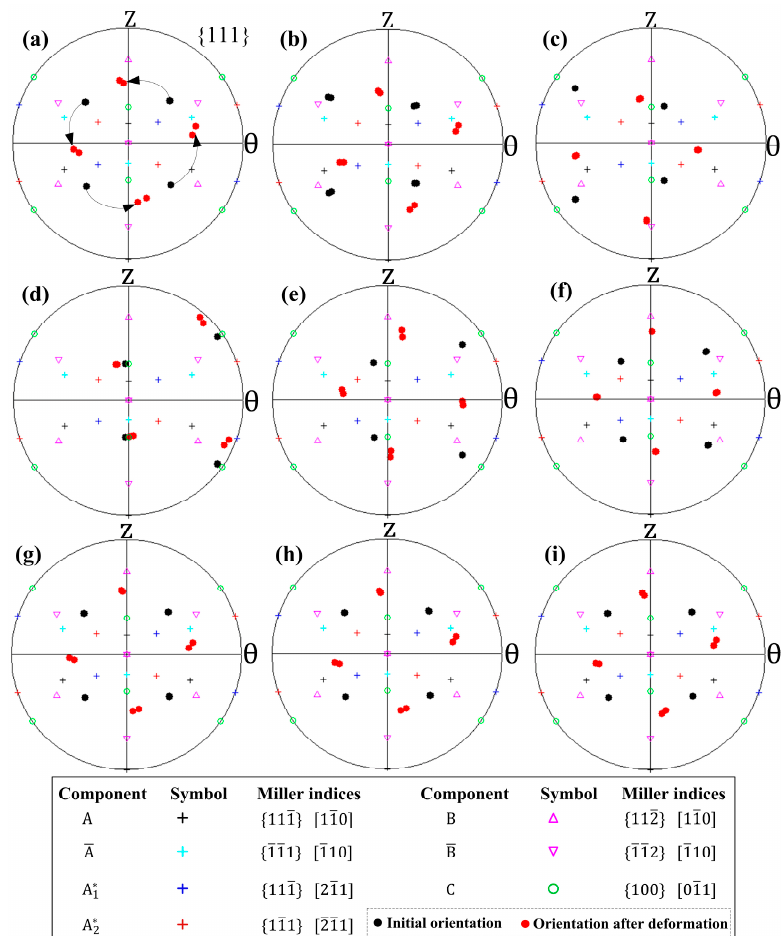
Figure 3. The predicted {111} pole figures of the (001) aluminum single crystal in the tangential direction after N = 1/12 turn of HPT deformation. The pole figure were recorded at radius ( r 0 /r ∼ =1) with ϕ = ( a ) −30° , ( b ) −15° , ( c ) 0° , ( d ) 18° , ( e ) 30° , ( f ) 45° , (g) 60° , ( h ) 150° and ( i ) −120° .